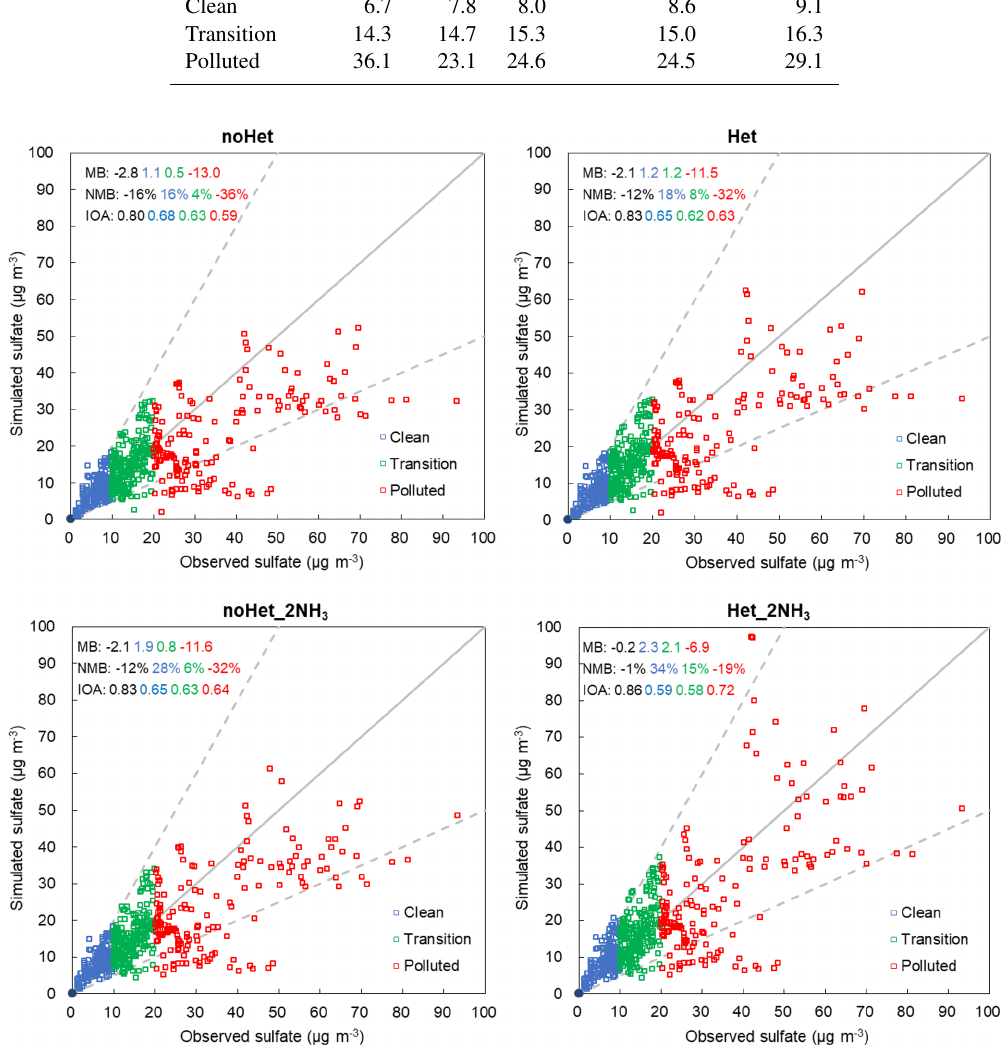
Figure 6. Scatter plots of hourly sulfate concentrations for different scenarios at the SAES site during 1 to 29 December 2013. Solid lines indicate 1 : 1 lines and dashed lines are 1 : 2 and 2 : 1